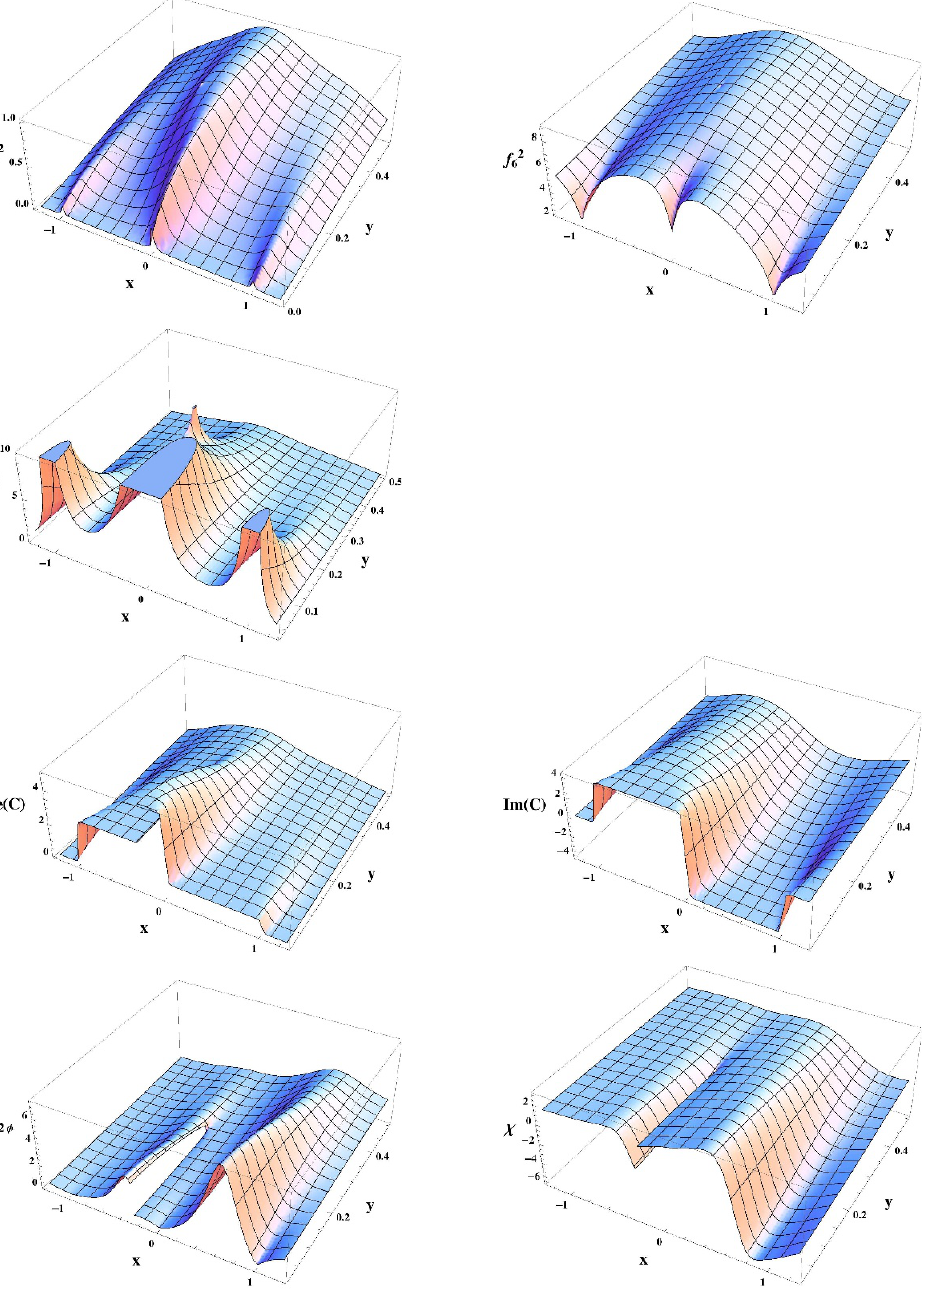
Figure 5 . The metric factors f 2 C and axion and dilaton for the 3-pole solution with [0 ; 1] monodromy.